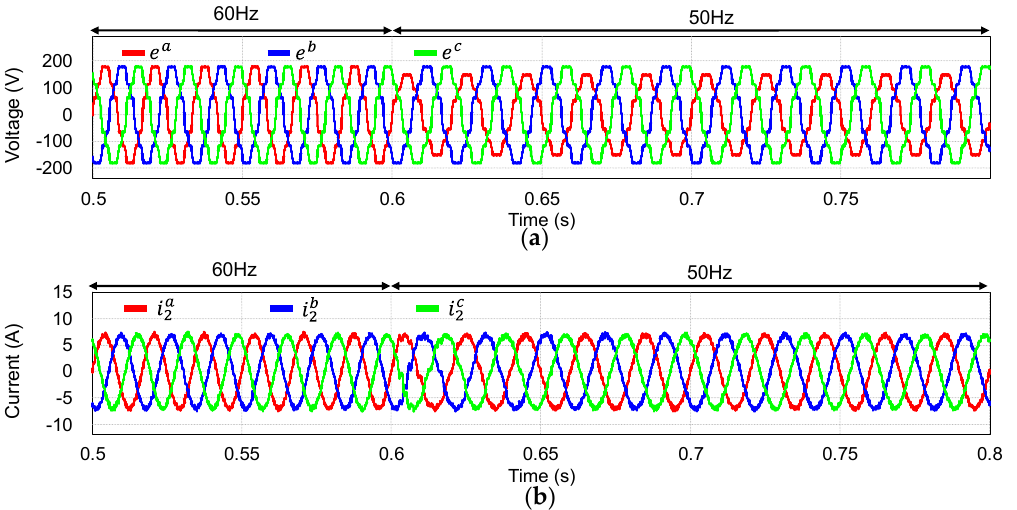
Figure 13. Simulation results for the proposed control scheme when the grid voltages have harmonic distortion, imbalance ( e a drops to 83.33% of the nominal value), and frequency change from 60 Hz to 50 Hz at 0.6 s. ( a ) Three-phase grid voltages; ( b ) three-phase grid currents.